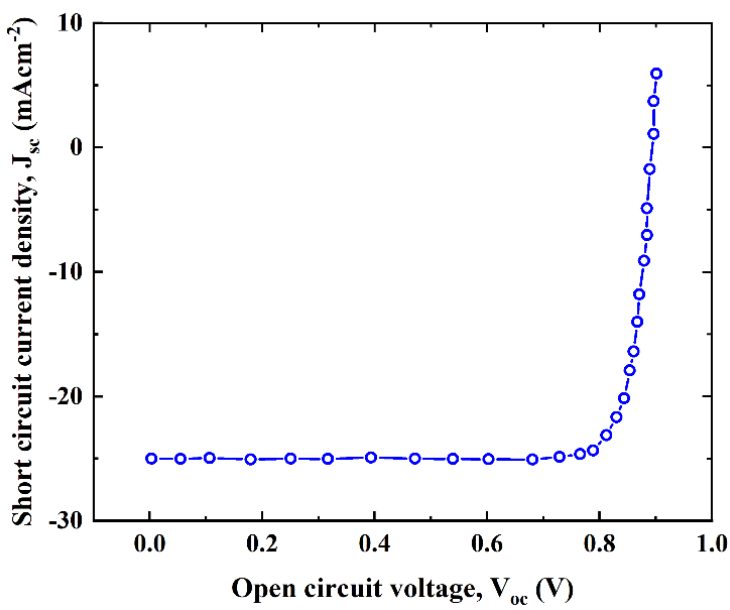
Figure 9. Quantum efficiency versus wavelength.